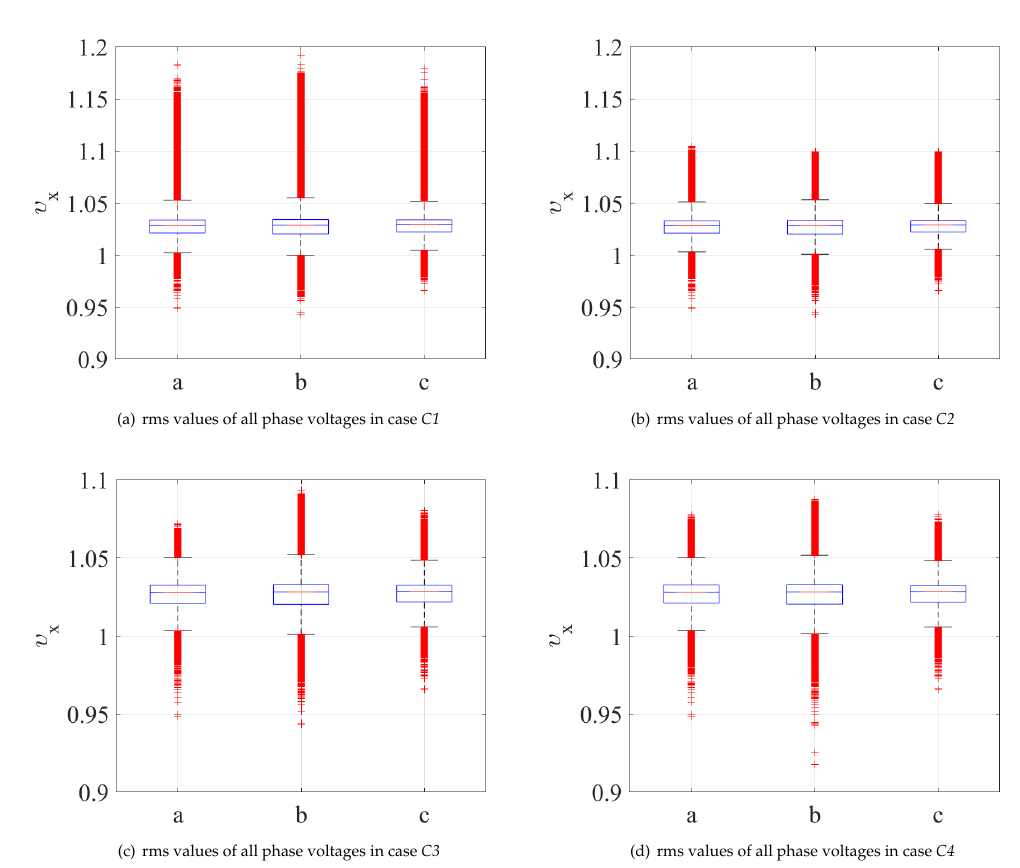
Figure 7. Concatenated voltage results of the entire LV grid when cases C1 to C4 are examined